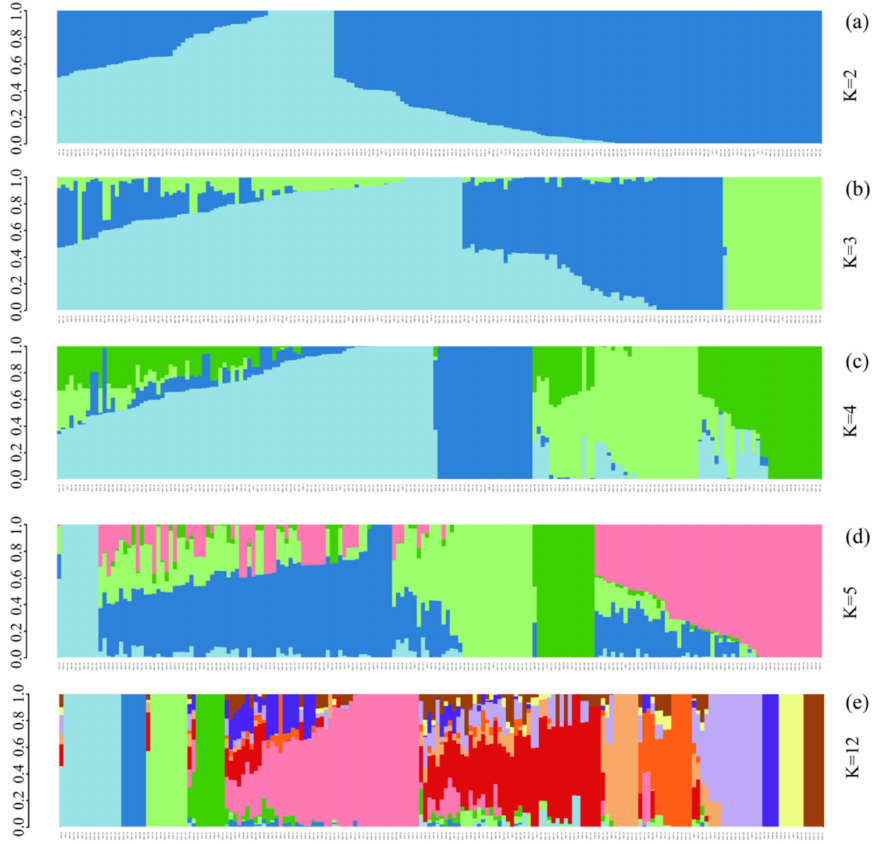
Figure 1. Results of an ADMIXTURE analysis of 185 Chinses chestnut landraces. ( a ) k = 2, ( b ) k = 3, ( c ) k = 4, ( d ) k = 5 and ( e ) k = 12. The K value represents the number of different subgroups, and different colors represent different